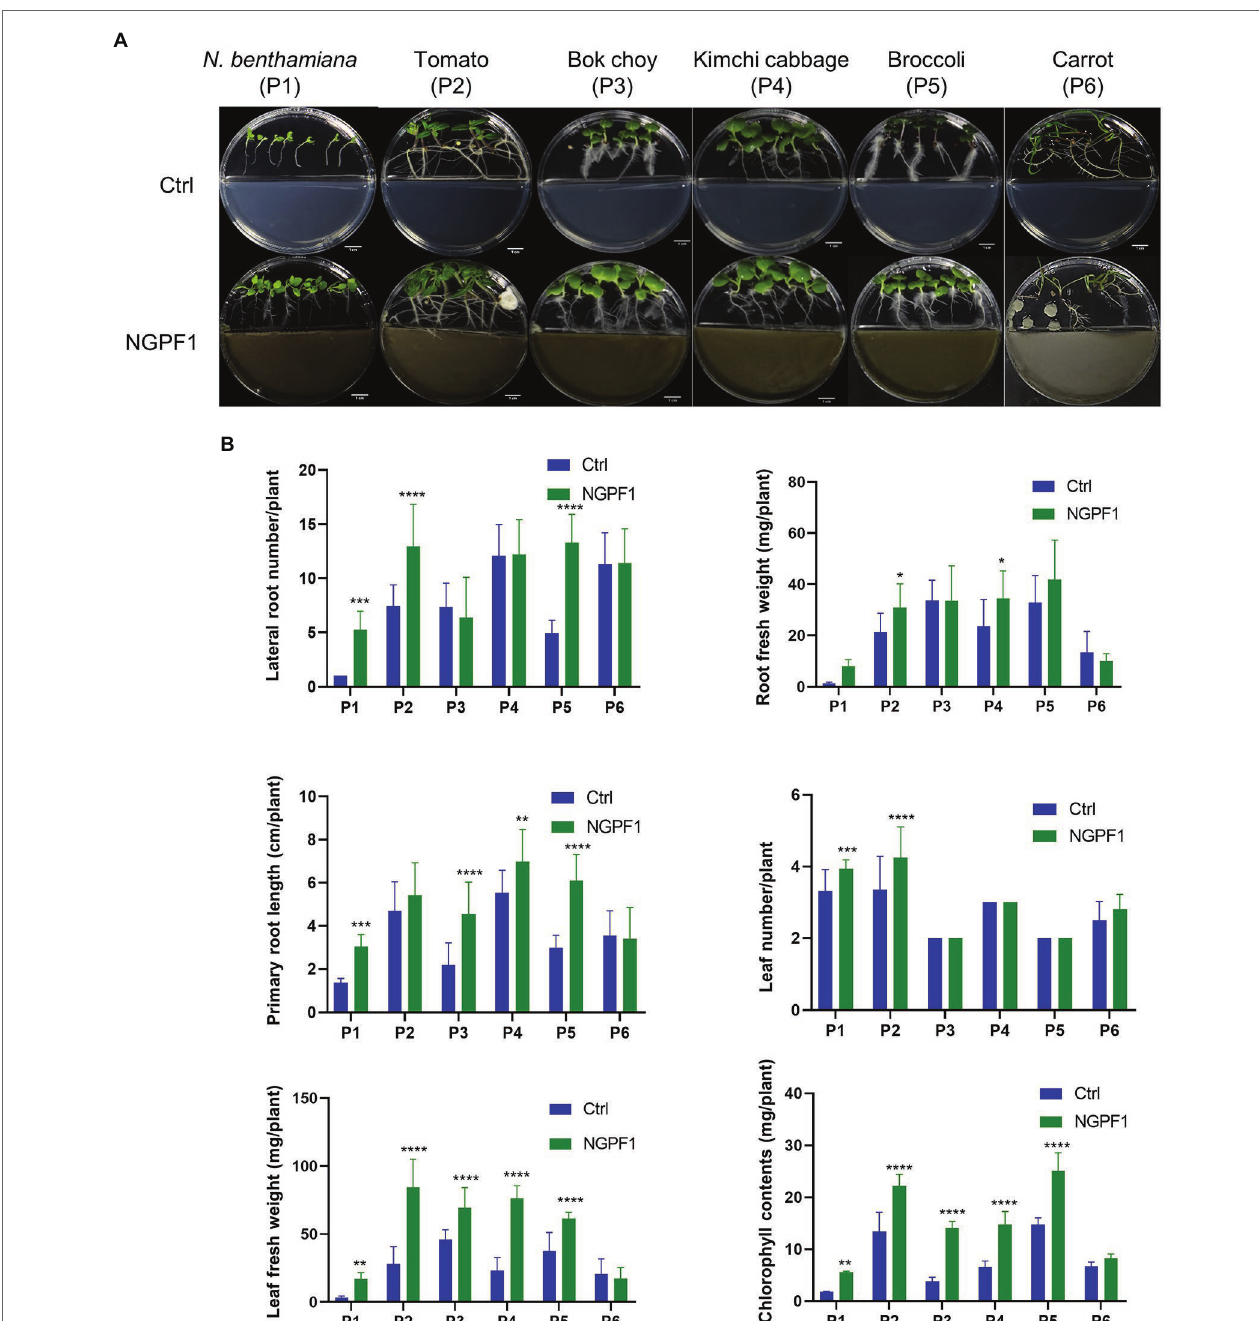
FIGURE 2 | Effects of VOCs of Cladosporium halotolerans NGPF1 on plant growth enhancement in vitro . Growth of N. benthamiana (P1), tomato (P2), bok choy (P3), kimchi cabbage (P4), broccoli (P5), and carrot (P6) in a shared atmosphere with Cladosporium halotolerans NGPF1 (A) for 4 days, except P1 and P2 for 10 days. (B) The effects of VOCs on leaf fresh weight, root fresh weight, leaf number, lateral root number, root length, and chlorophyll contents were recorded after 4 days and 10 days exposure. Error bars indicate the standard deviation of the mean ( n = 18). Asterisks indicate a statistically significant difference between control (ctrl, no treatment) and NGPF1 treatment (two-way ANOVA, * p < 0.05, ** p < 0.01, *** p < 0.001, and **** p <